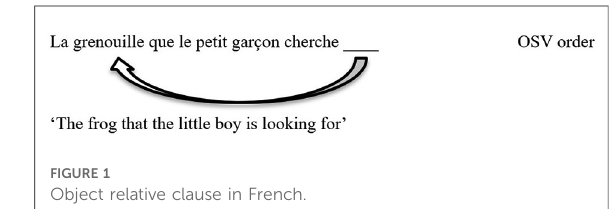
FIGURE 1 Object relative clause in